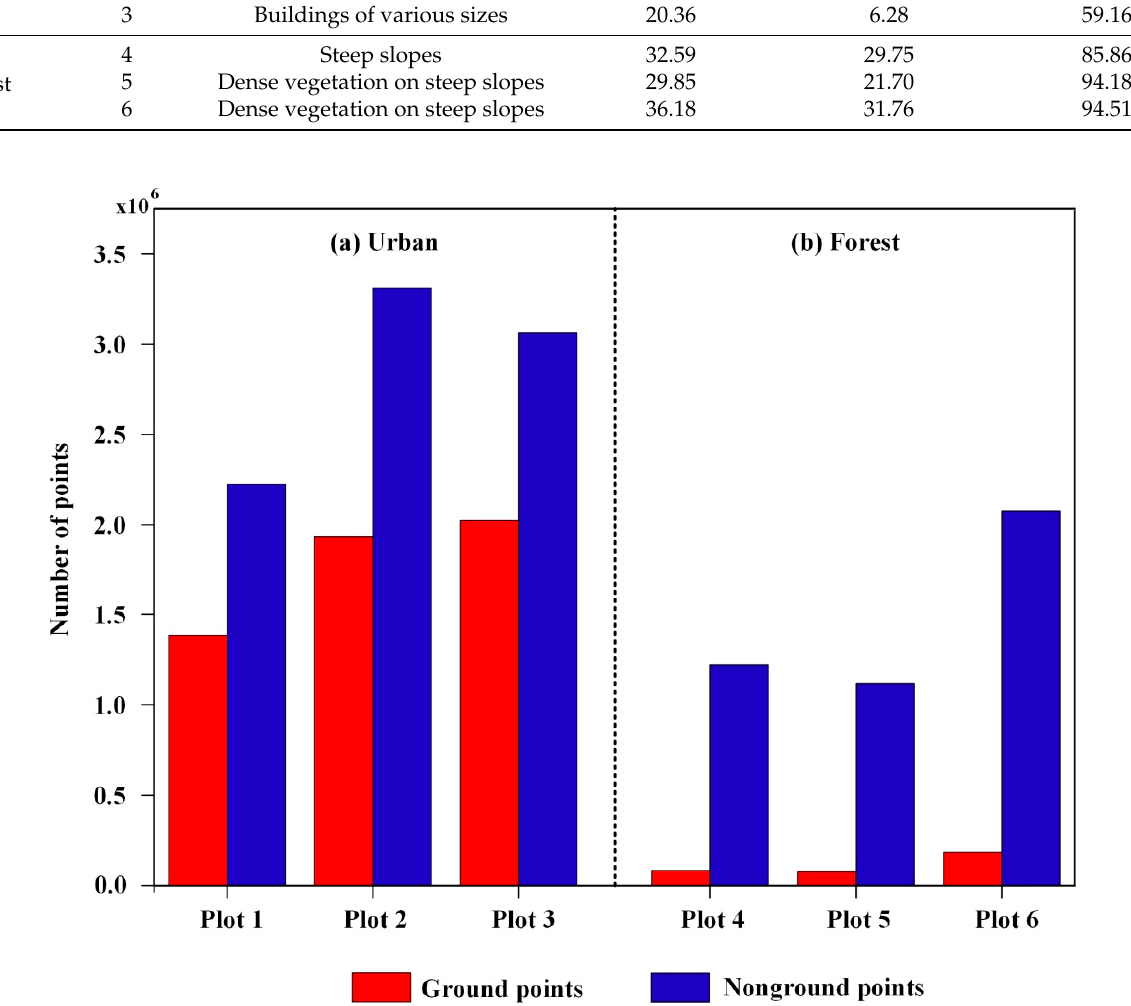
Figure 7. Numbers of BE and OBJ points for the six study sites. Compared to OBJ points, BE points in the forest plots are obviously fewer than in the urban plots.